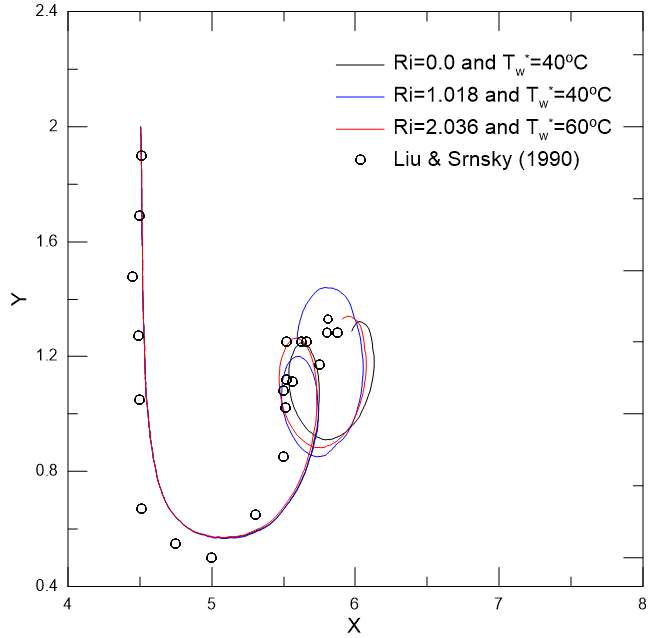
Figure 6. Predicted trajectories for the right-side vortical structure from the wing tip not using crosswind interference (T ∞ * = 20 ◦ C, Pr = 0.7, and Re = 7650): without buoyancy effects (Ri = 0.0) and with buoyancy effects (Ri (cid:54) = 0.0)